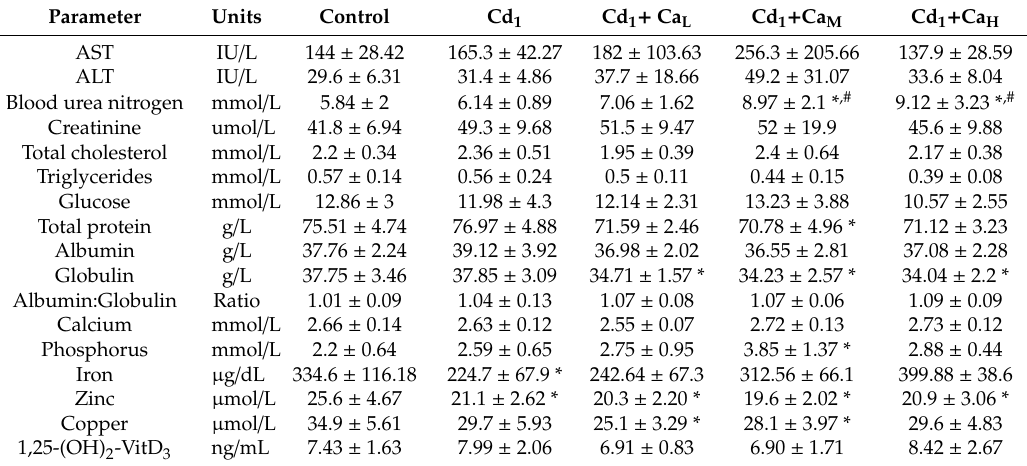
Table 5. Serum chemistry parameters of female rats after 90 days in the study of Ca supplementation with dietary exposure to 1 mg Cd / Kg (Exp.